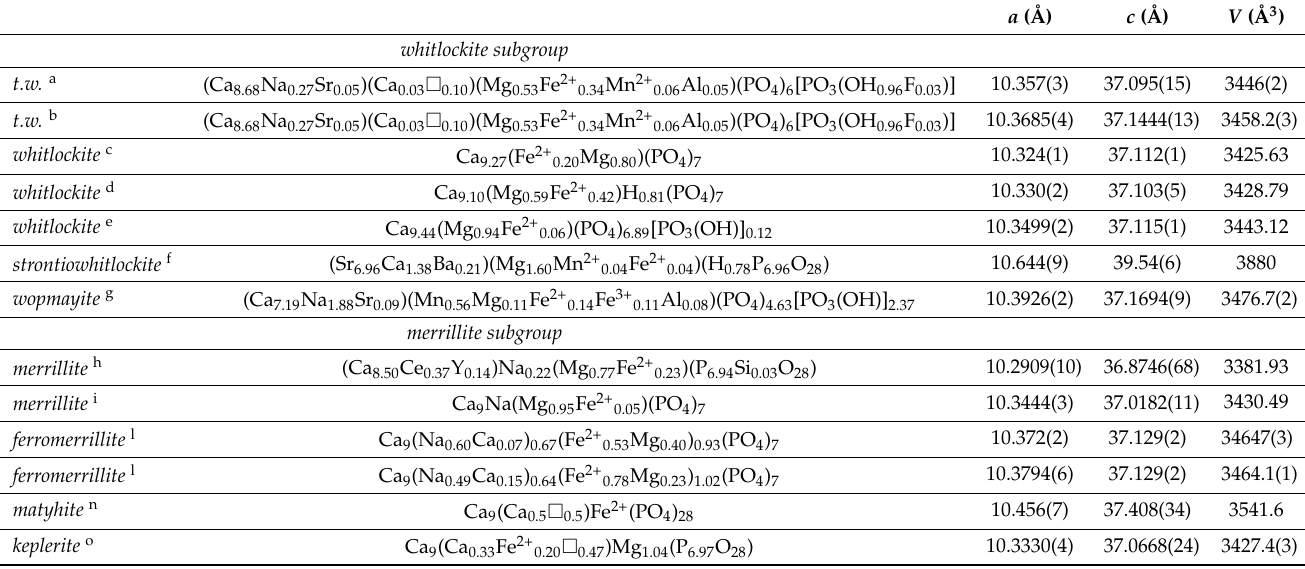
Table 4. Unit cell parameters and chemical formulas for merrillite and whitlockite subgroups